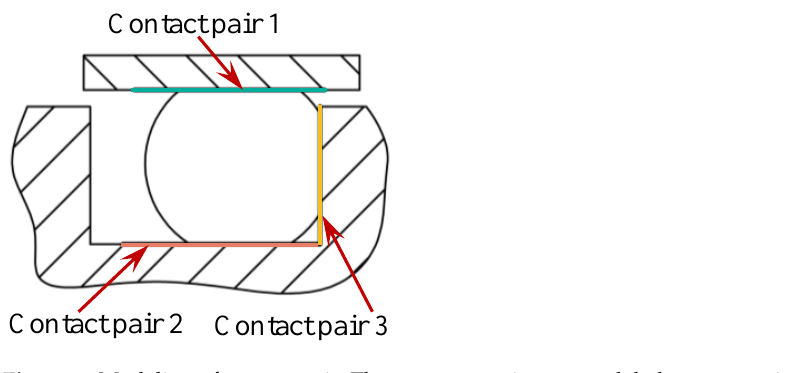
Figure 3. Modeling of contact pair. Three contact pairs are modeled, contact pair 1 is between piston rod and rubber ring, contact pair 2 is between groove side and rubber ring, contact pair 3 is between groove bottom and rubber